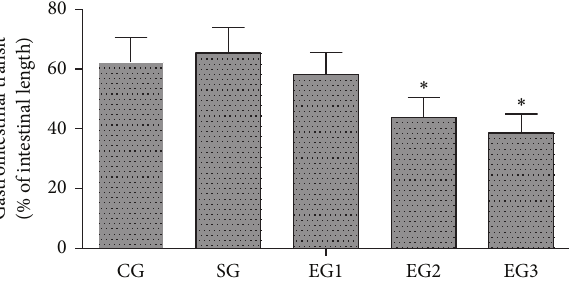
Figure 1: Gastrointestinal transit. CG: control group; SG: sham group; EG1, EG2, and EG3: exposure groups with peritoneal air exposure for 1, 2, and 3h, respectively. The data are expressed as mean ± SD, 𝑛 = 8 . ∗ 𝑃 < 0.05 , versus the CG